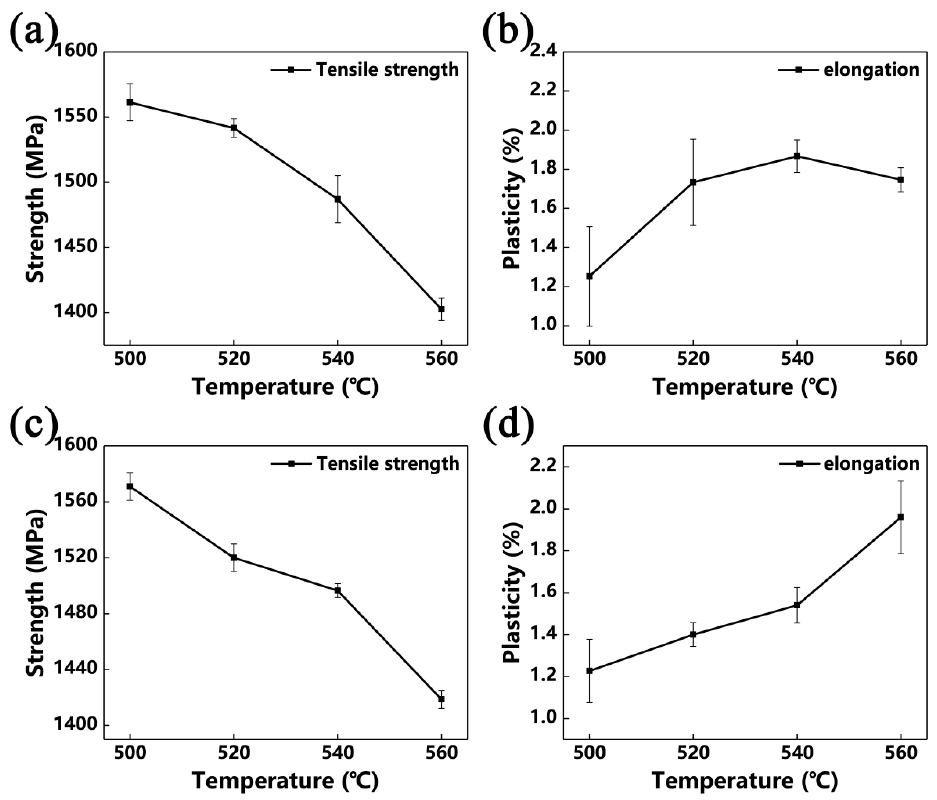
Figure 13. Tensile properties of Ti-35421 that was solution-treated at the β region for 0.5 h and with 8 h aging: ( a , b ) solution-treated at 820 °C; ( c , d ) solution-treated at 840 °C.